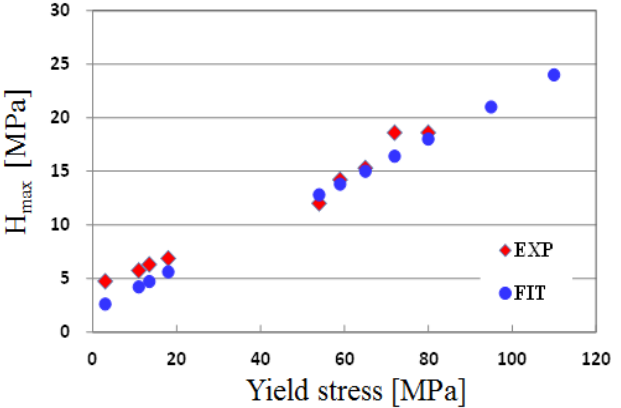
Figure 3. Relation between the maximum work-hardening and initial yield stress and fitted data using Equation (4).